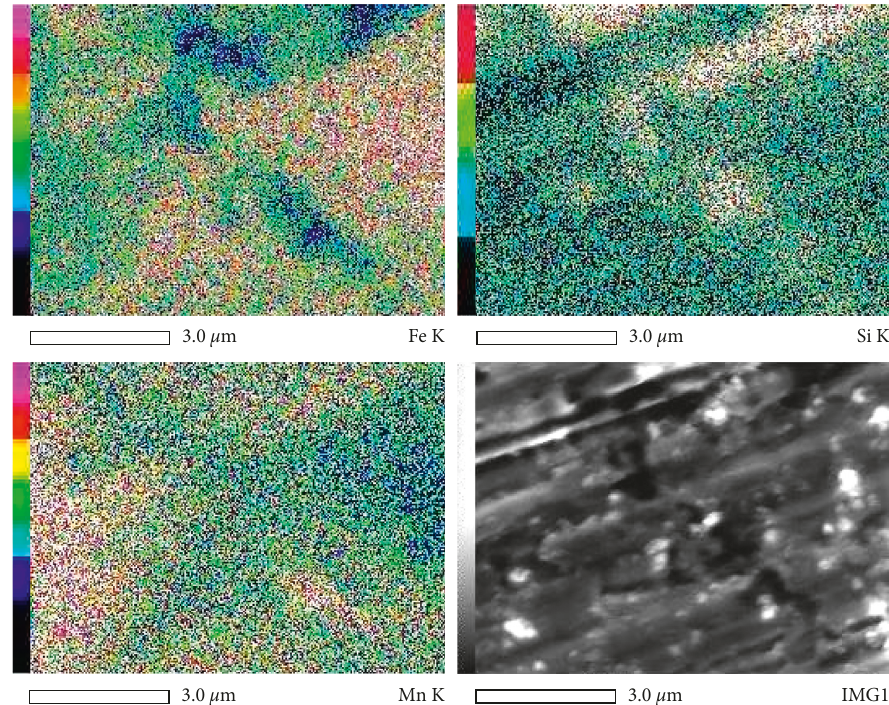
Figure 3: SEM and EDX analysis of Fe-30Mn-6Si bulk alloy after sintering and annealing with preceding MA treatment.